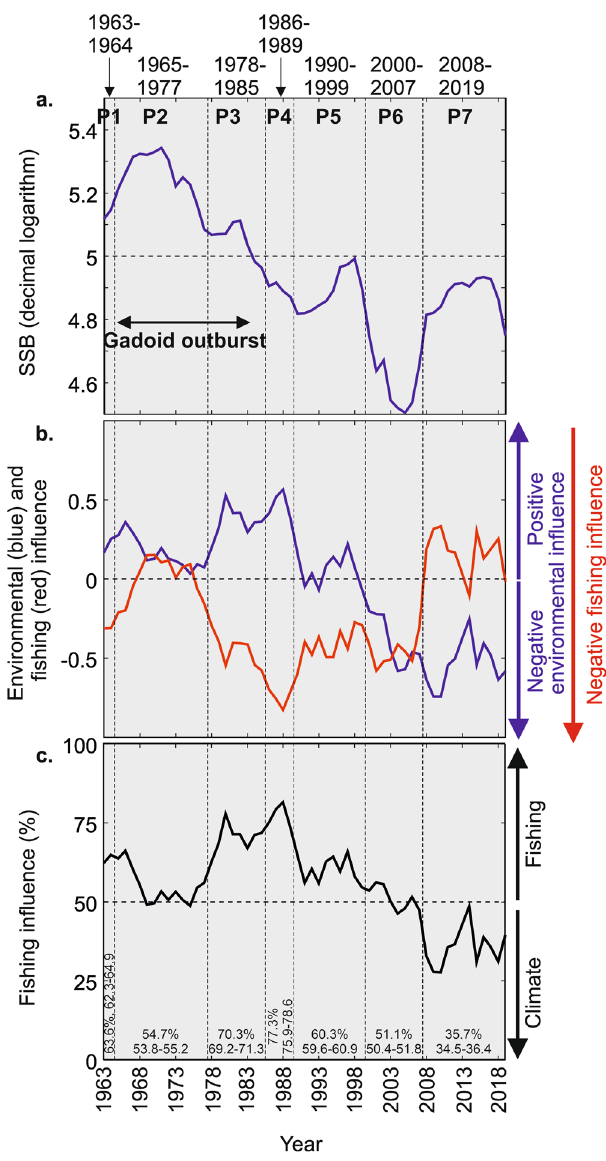
Fig. 2 Respective contribution of the in fl uence of the environment and fi shing intensity on Spawning Stock Biomass (SSB) for 1963-2019. a Long-term changes in ICES SSB (decimal logarithm). The timing of the Gadoid Outburst is indicated. b Long-term changes in the estimated positive environmental (blue) and negative fi shing intensity (red) in fl uence on SSB. c Long-term quanti fi cation of the fi shing/environmental in fl uence on SSB. Dashed black vertical lines denote the different time periods P1-P7 identi fi ed by the cluster analysis based on the time series shown in ( a , b ). A quanti fi cation of the in fl uence of fi shing (in percentage) is indicated at the bottom of panel c for each time period (average, minimum and maximum values) after applying a jackknife